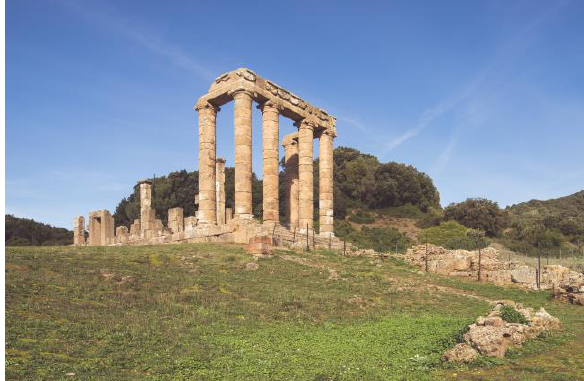
Figure 2. Workflow and output